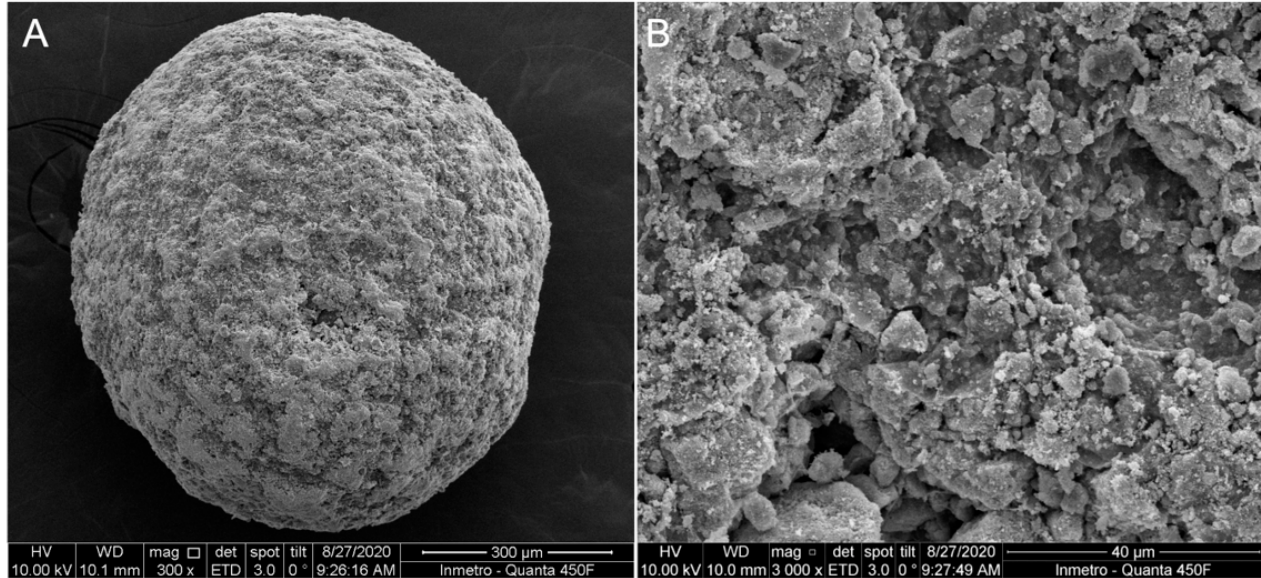
Figure 3. SEM images of HA microspheres at lower magnification ( A ) and higher magnification ( B ).